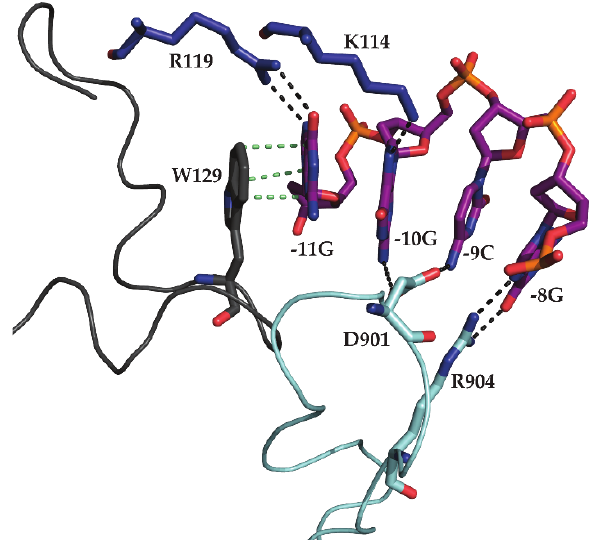
Figure 5. Summary of all sequence specific contacts required for mini-vRNAP recognition of early promoter P2. Promoter DNA represented as purple sticks. Mini-vRNAP structural motifs involved in recognition are represented as ribbons, with individual residues highlighted as sticks. Direct interactions are represented as dark grey (hydrogen bonds) or green (base stacking) dashed lines. W129 of the (cid:5)11 recognition element (light grey) base-stacks with the (cid:5)11G residue in the hairpin loop. Fingers domain (dark blue) residues K114 and R119 hydrogen bond with (cid:5)10G and (cid:5)11G, respectively. Specificity loop (cyan) residues D901 and R904 contact (cid:5)9C/(cid:5)10G and (cid:5)8G through the major groove of the hairpin stem,